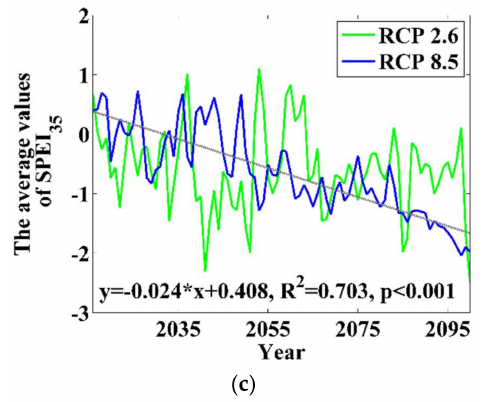
Figure 9. Changes in SPEI over time under scenarios RCP 2.6 and RCP 8.5 on time scales of ( a ) 23 months; ( b ) 24 months; and ( c ) 35 months. The 24 months represent the optimal time scale of SPEI for the three groups of stock volume density: 30–60, 60–90, 90–120 m 3 · ha − 1